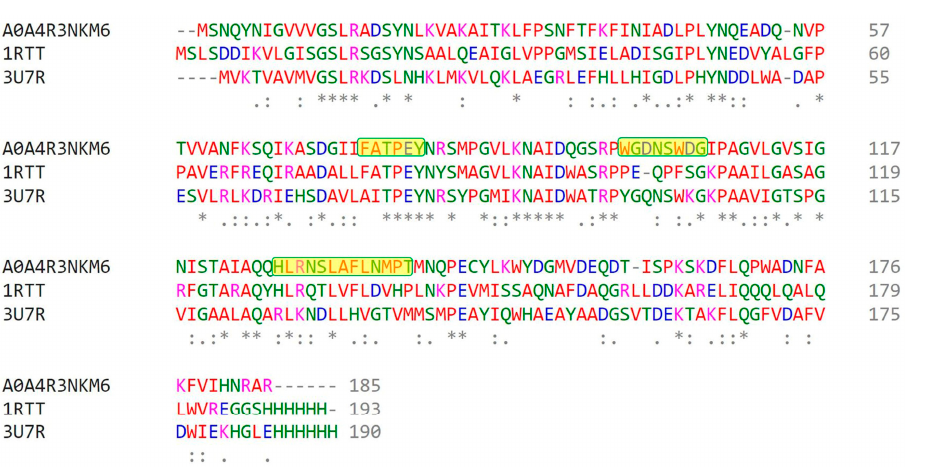
Figure 3. Multiple sequence alignment of P. alcalifaciens and orthologous protein sequences of ChrR that are substantially comparable. The asterisk at the bottom of the alignment indicates conserved residues; the colon implies conservation between categories of features that are highly comparable; while the period denotes conservation between groups with weakly related features. The highlighted boxes represent identified